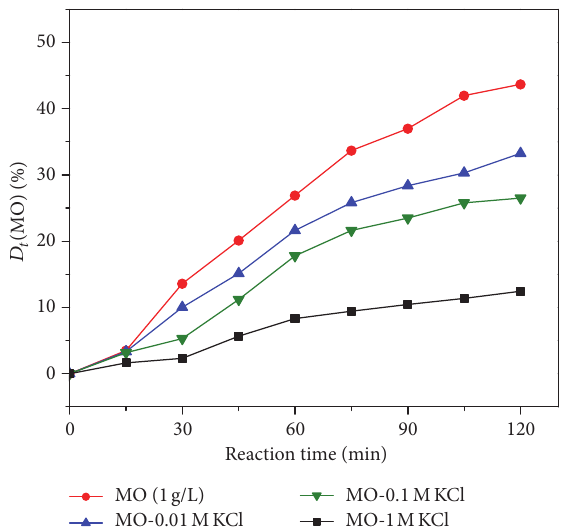
Figure 6: Variation of 𝐷 𝑡 (MO)s with MO (0.1 g/L) in different concentration KCl solution under 254 nm UV at RT.